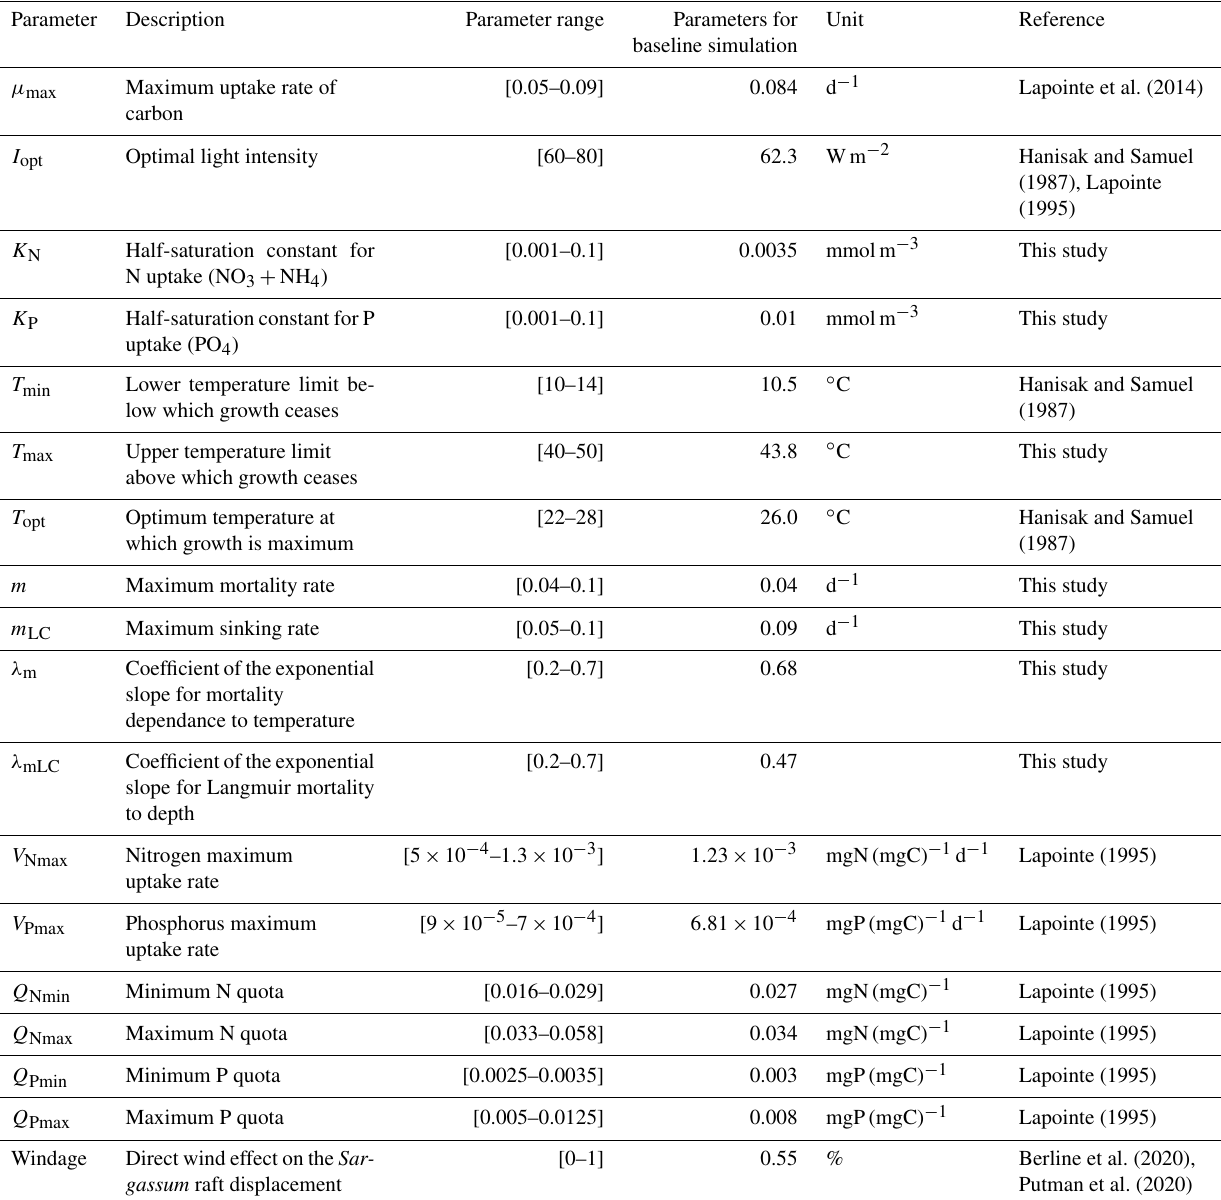
Table 1. Sargassum model